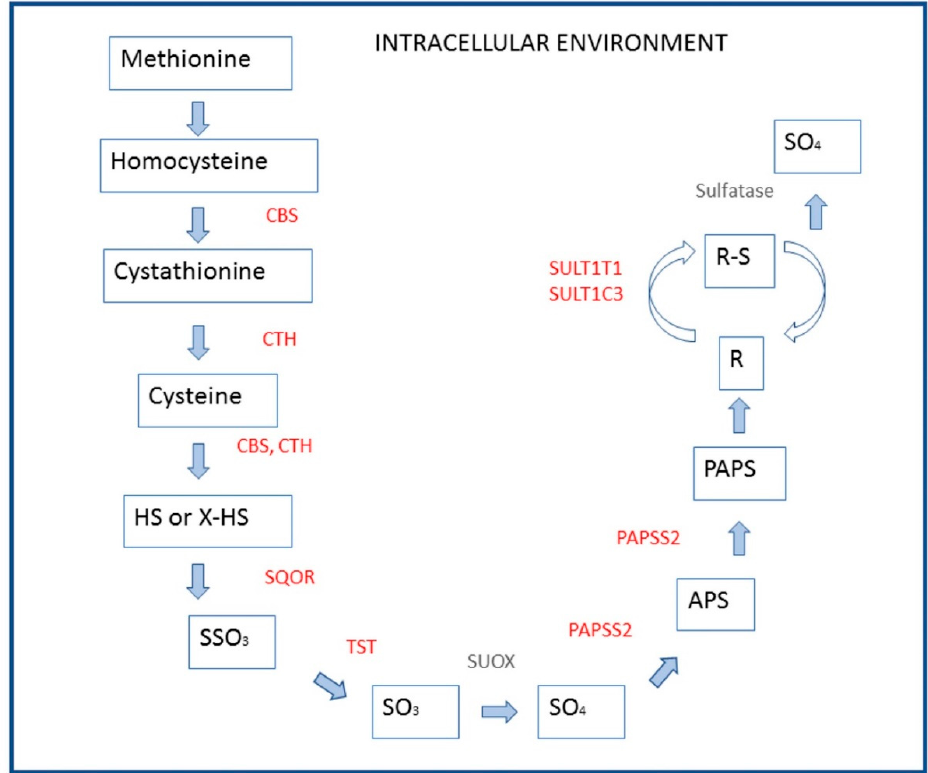
Figure 3. Gene enrichment in the cysteine and methionine catabolism, sulfate metabolism, and disulfide oxidoreductase activity in the cecum of broiler chickens. Genes over-expressed in the cecum with respect to the jejunum are shown in a red color (FDR > 2, except SQOR (sulfide quinone reductase) at least = 1.8). The alternative sulfate-generating pathway controlled by cysteine dioxygenase type 1 ( CDO1 ) is not represented, because the gene coding this enzyme was mildly expressed, with values not differing to jejunum mucosa . CBS = cystathionine β -synthase; CTH = cystathionine γ -lyase; SQOR = sulfide quinone reductase; TST = thiosulfate sulfurtransferase; SUOX = sulfite oxidase (not spotted on chicken microarrays); APS = 5’ adenosine-phosphosulfate; PAPS = 3’-phosphoadenosine 5’-phosphosulfate; PAPSS2 = PAPS synthetase; SULT1E1 and SULT1C3 sulfotransferase, family 1C member 3 and family 1E member 1; GOT2 = glutamic–oxaloacetic transaminase 2; 3-MPY = 3-mercaptopyruvate; MPST = 3-mercaptopyruvate sulfurtransferase; PY = pyruvate; TXN = thioredoxin. Adapted from Reference [11].